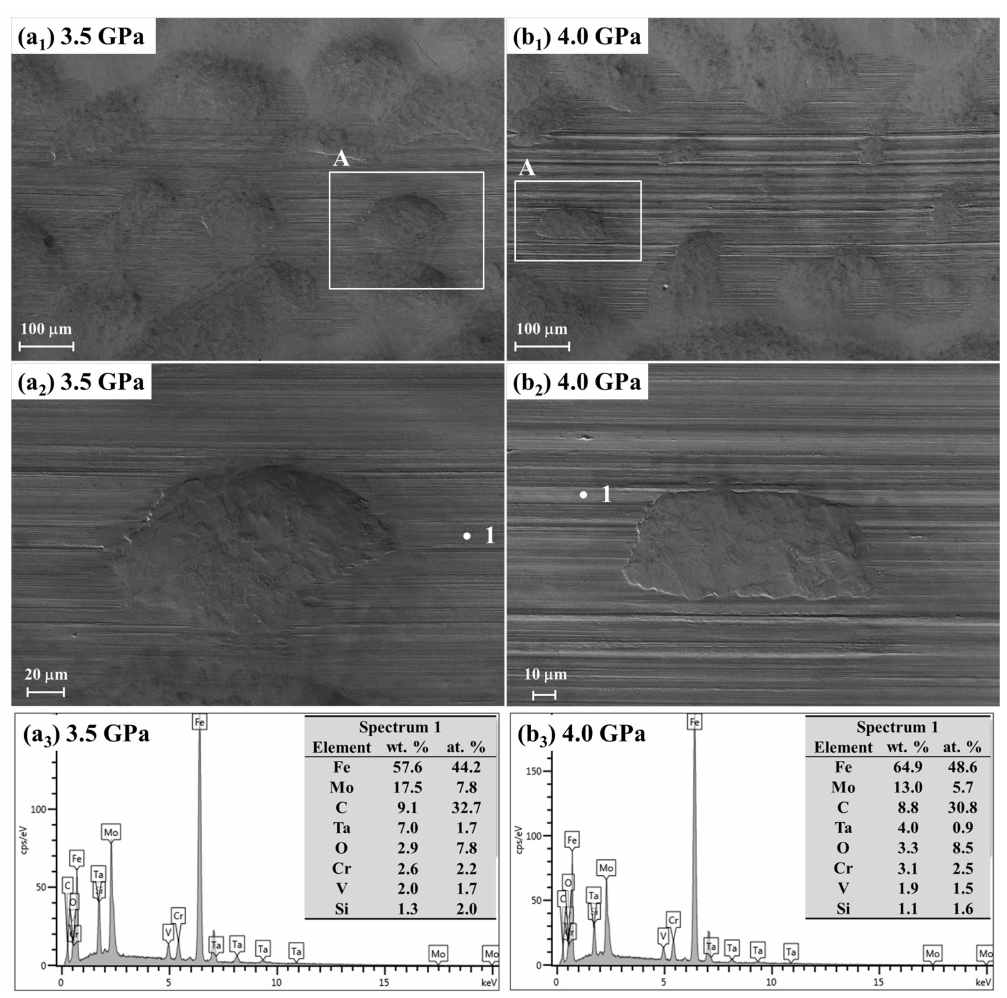
Figure 9. SEM/EDS wear topography characterization of HCPEB-treated Ta coating after sliding in pure JP-10 against a Si 3 N 4 ball at room temperature in ambient atmosphere: ( a 1 , b 1 ) overview SEM images under 3.5 GPa and 4.0 GPa, respectively; ( a 2 , b 2 ) high-magnification SEM images of regions A in ( a 1 , b 1 ), respectively; ( a 3 , b 3 ) EDS spectra of points 1 in ( a 2 , b 2 ), respectively.